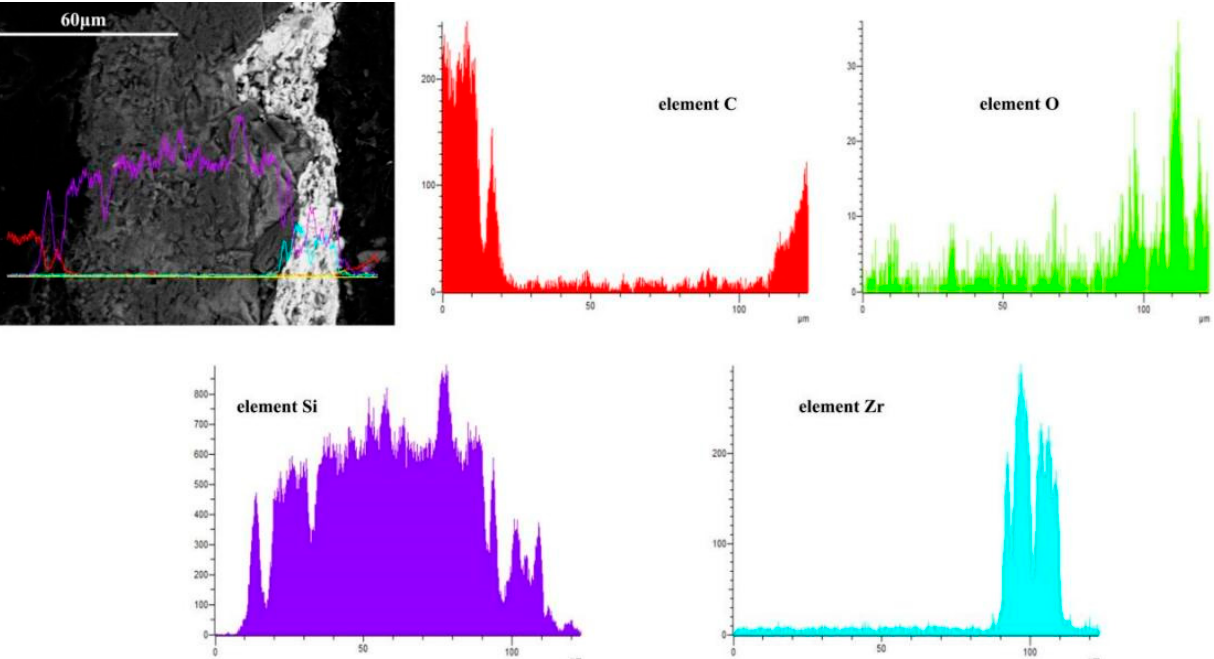
Figure 6. The EDS results of the cross section of the C/C composites with the ZrSi 2 -SiC/SiC coating (30 wt.% ZrSi 2 -70 wt.% SiC).